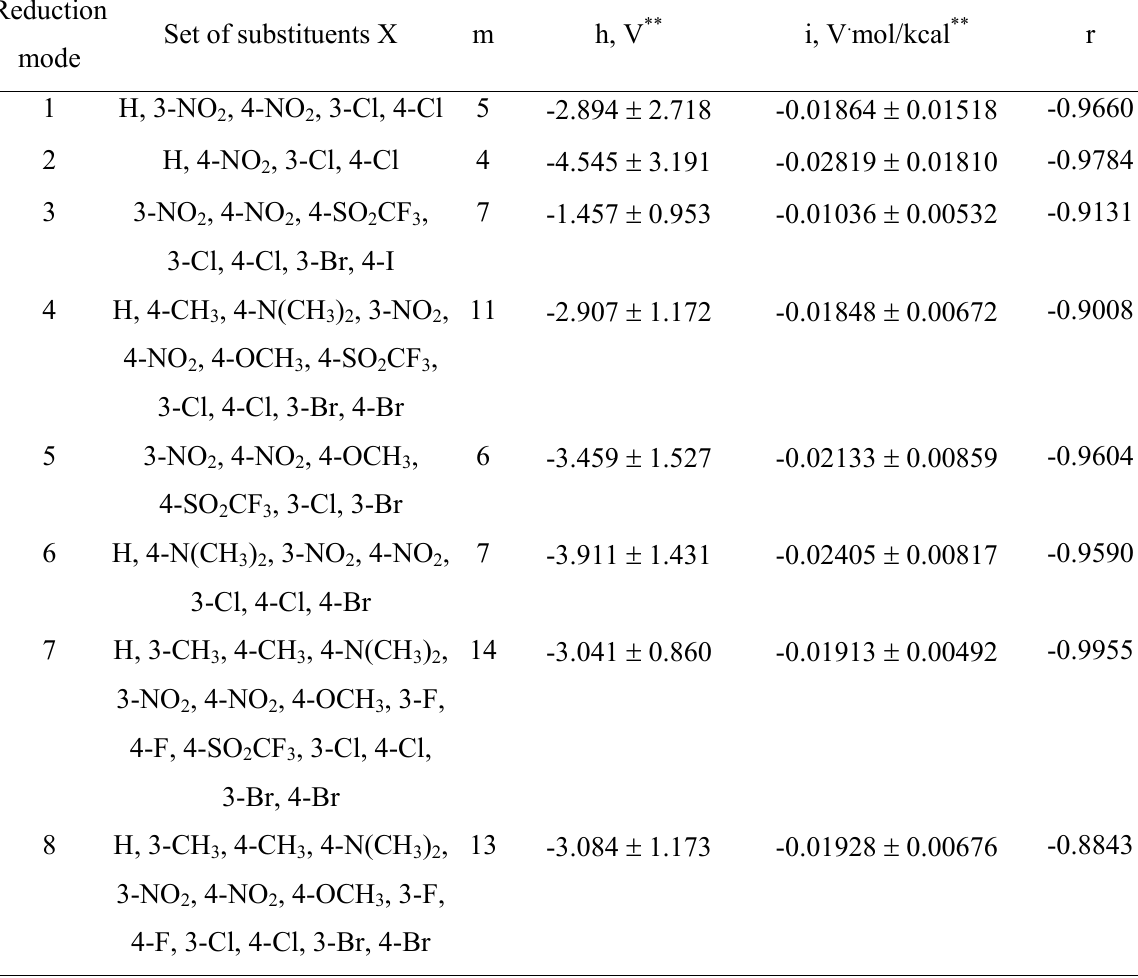
H N + ≡ N cations titration, potentials 6 4 Cl electrode) [5-7, 11], with free energies ( ∆∆ G 2 2